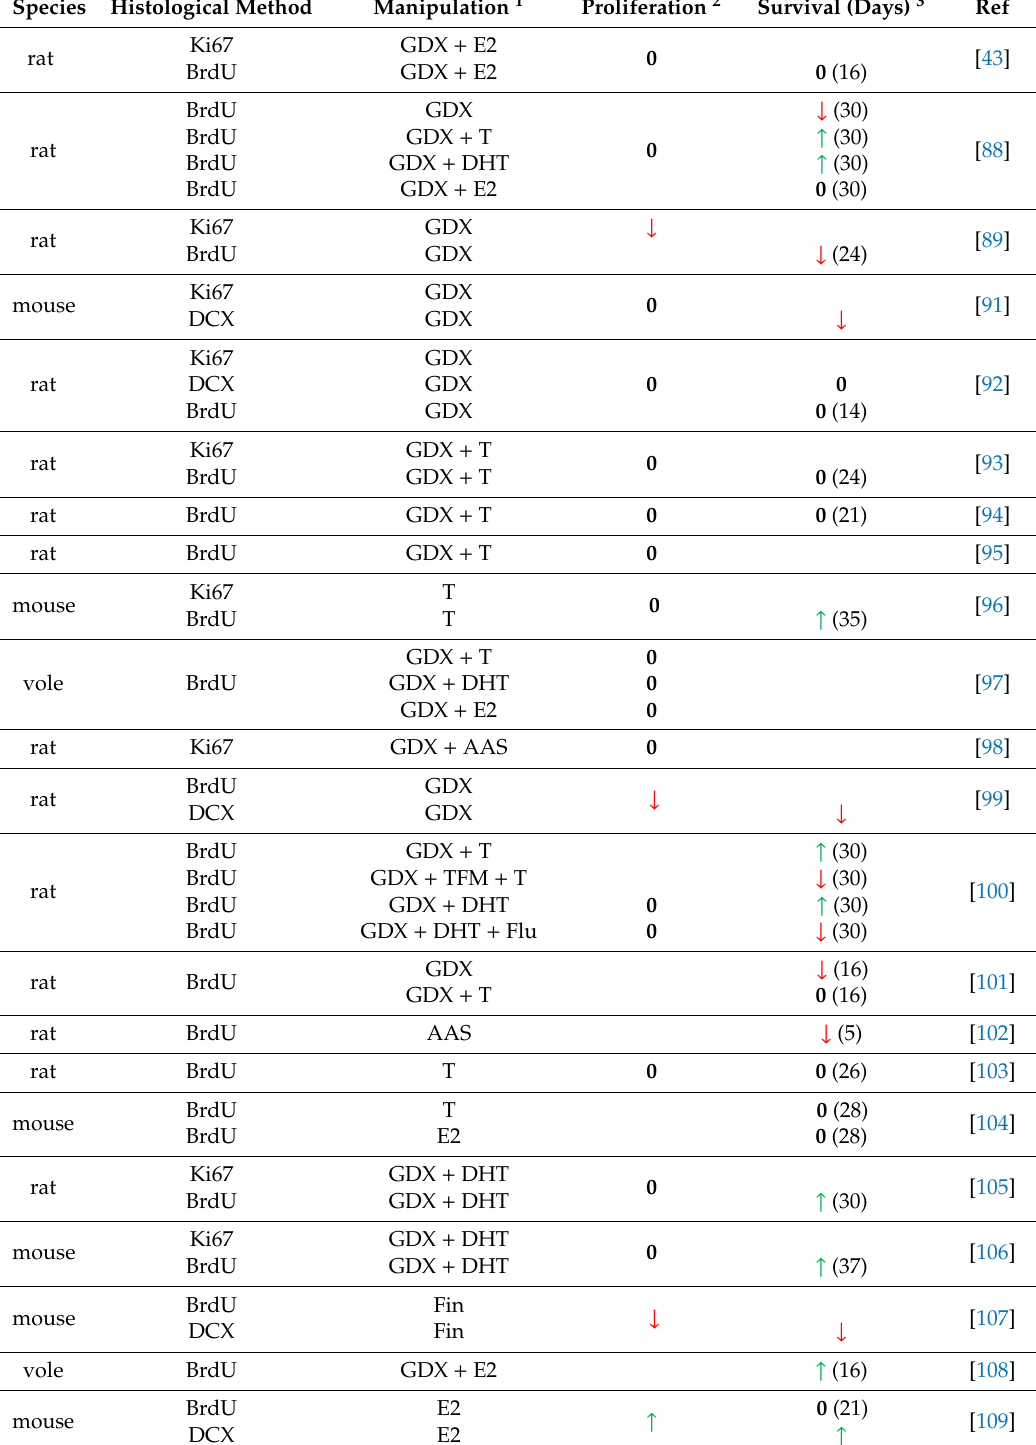
1 Experimental manipulations of animals: gonadectomy (GDX); testosterone administration with or without gonadectomy ( + T); estradiol administration ( + E2); DHT administration ( + DHT); flutamide administration ( + Flu); anabolic androgenic steroids ( + AAS); testicular feminization mutation (TFM); finasteride administration (Fin). 2 The experimental manipulation may have increased ( ↑ ), decreased ( ↓ ), or had no e ff ect ( 0 ) on cell proliferation and / or cell survival. 3 Days refers to how old cells were at the time of assessment of cell survival, if known based on timing of BrdU